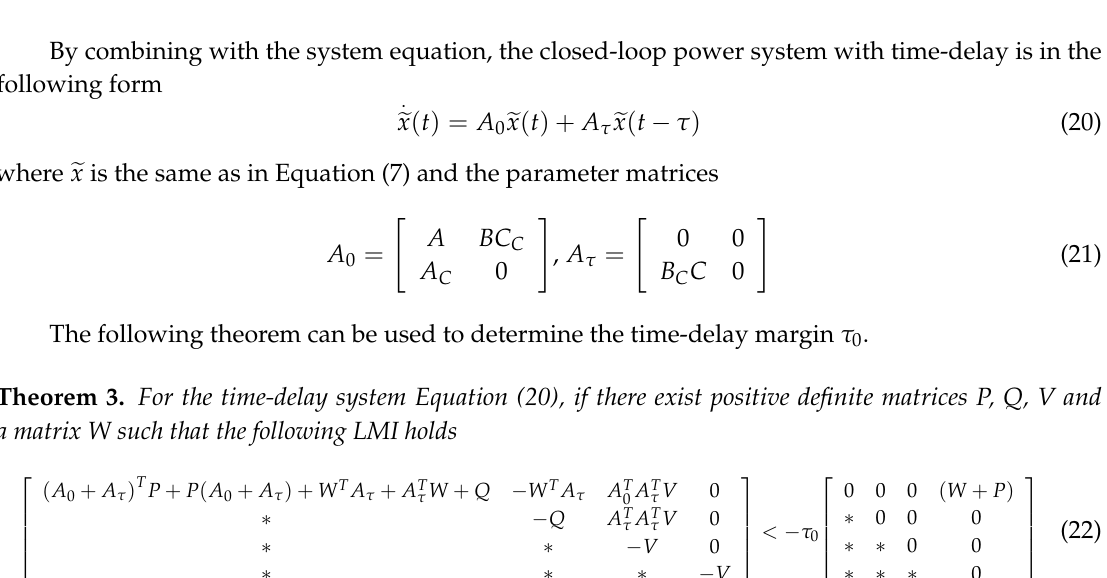
Figure 4. Closed ‐ loop time ‐ delay system under dynamic output feedback control. Figure 4. Closed-loop time-delay system under dynamic output feedback